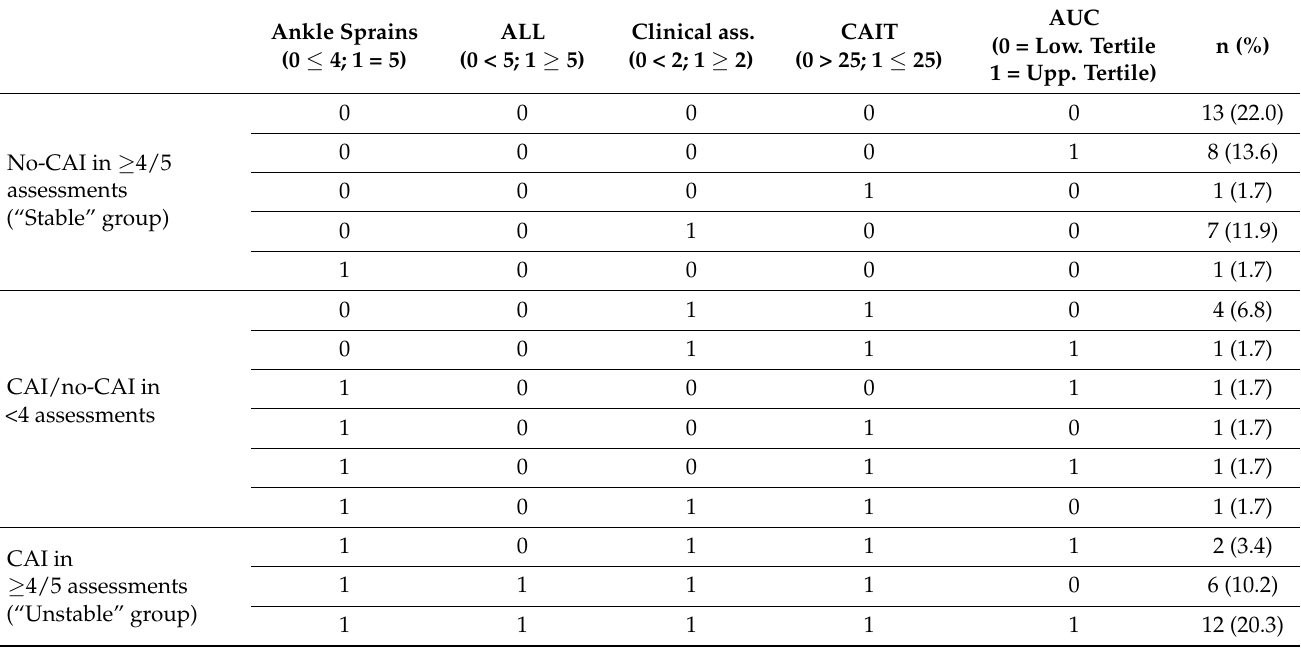
Table 3. Number and percentage of individuals with CAI (1) and with no-CAI (0) in the different mechanical/functional assessments.